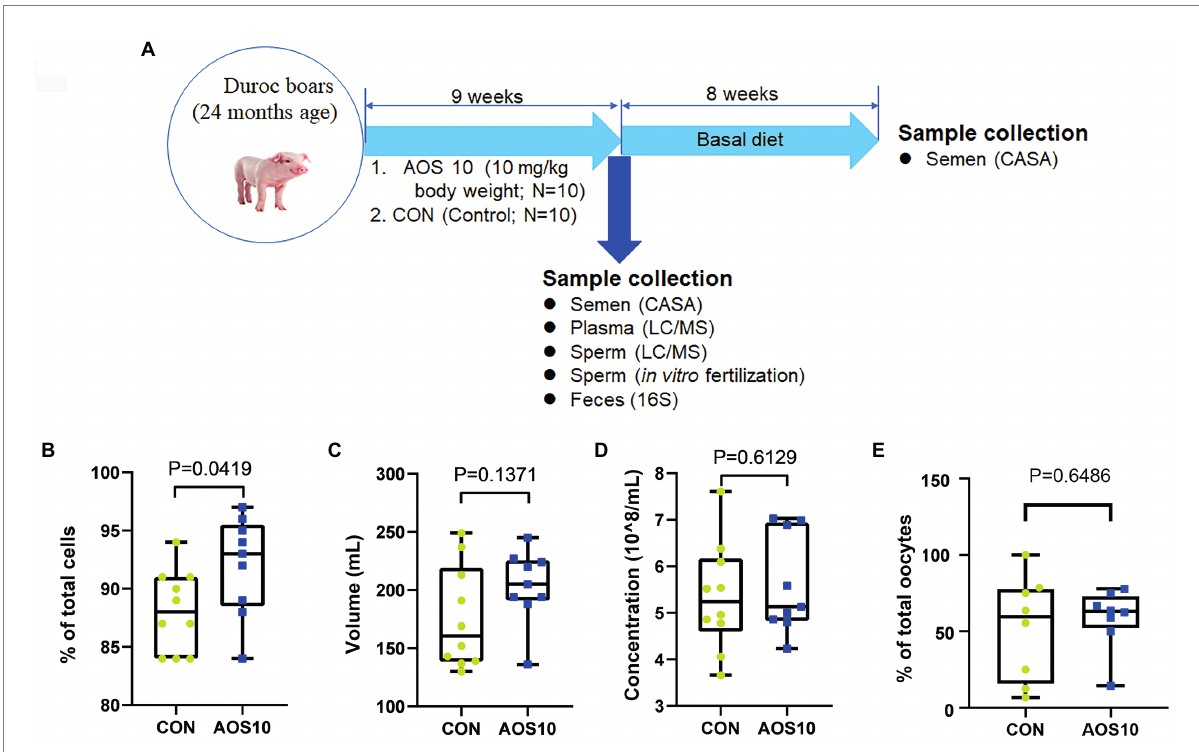
FIGURE 1 The impacts of AOS on boar sperm quality. (A) Study scheme. (B) Spermatozoa motility determined by CASA. Y-axis = % of total cells, X-axis = treatment group (mg/kg body weight). n = 10. (C) Semen volume. Y-axis = volume (ml), X-axis = treatment concentration (mg/kg body weight). n = 10. (D) Sperm concentration. Y-axis = sperm concentration (10^8/ml), X-axis = treatment group (mg/kg body weight). n = 10. (E) In vitro fertilization rate. Y-axis = % of total oocytes, X-axis = treatment group (mg/kg body weight). n =